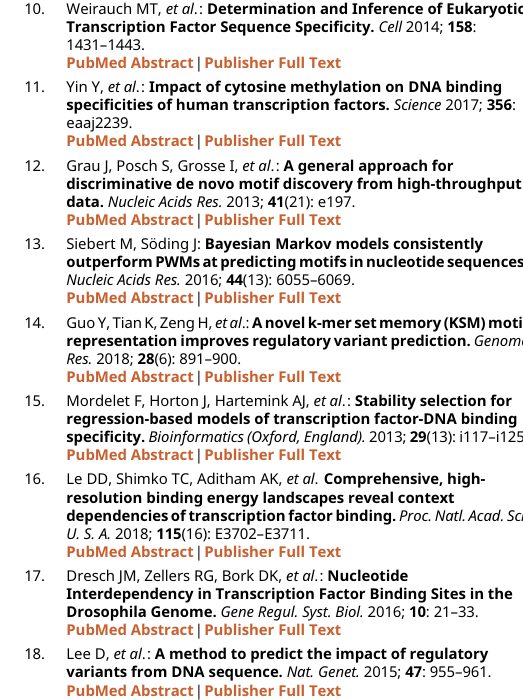
Figshare: PWM-evaluation-using-SNP-SELEX, https://doi.org/10.6084/m9.figshare.16906789.v1. 21